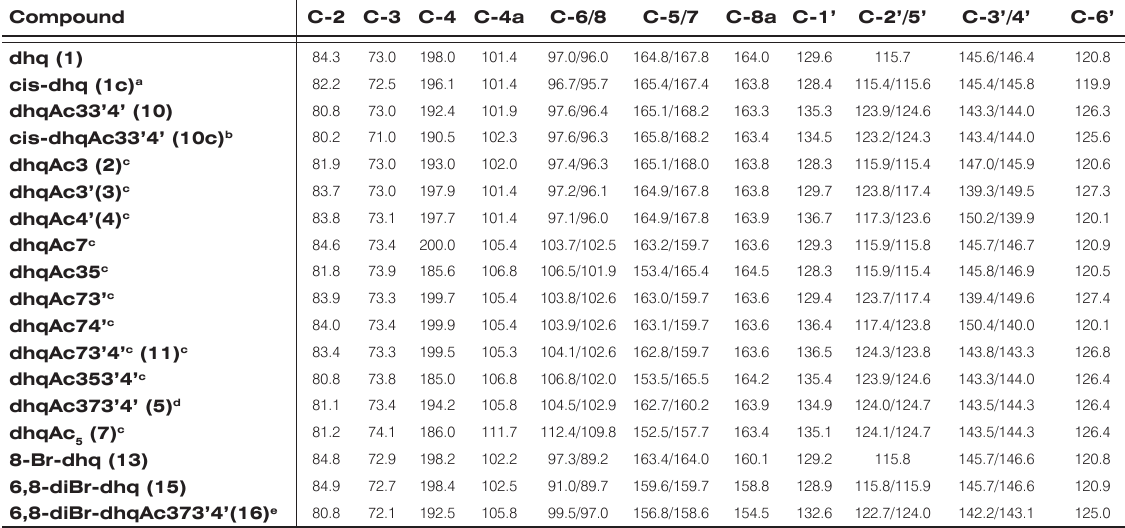
Table 2 . 13 C NMR Chemical Shifts (ppm) of Dihydroquercetin Derivatives Compound